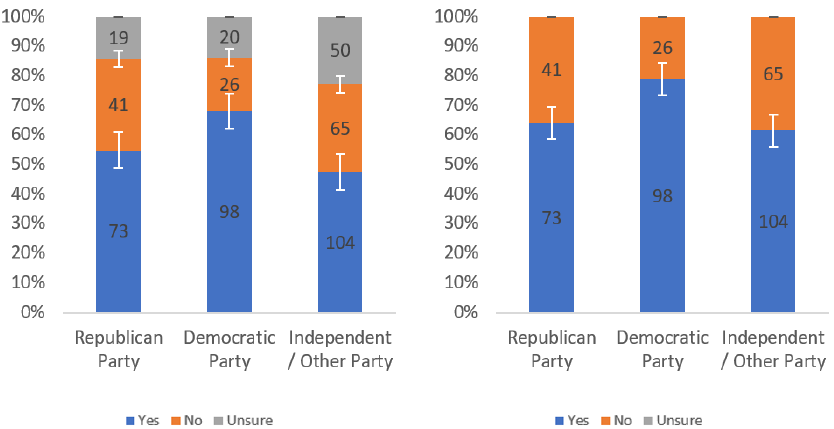
Figure A44. Responses regarding usefulness in judging trustworthiness by party affiliation including ( left ) and excluding ( right ) unsure responses.